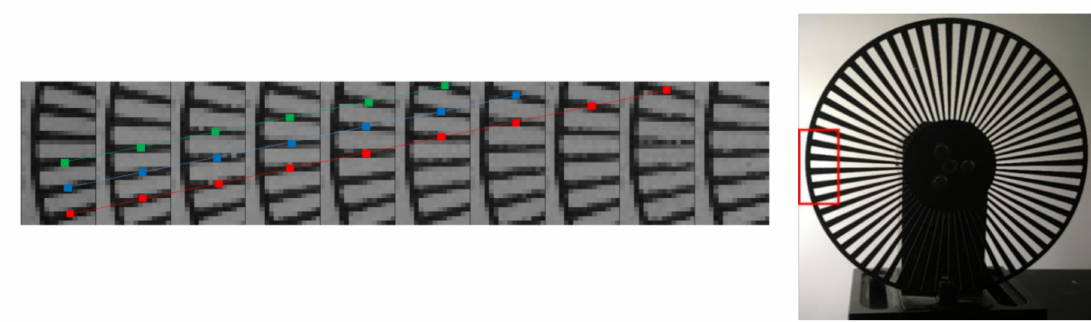
Figure 8. Confirmation of the pipeline signal transfer by the combination of four collection gates and four-phase CCD memories (the images were taken at 100 kfps; every 15 frames were selected, and stitched to show the smooth motion; the photo on the right side is a reference taken by a different camera).